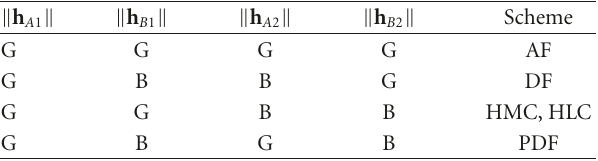
Table 2: Performance guideline for the two-way two-relay network in the medium SNR